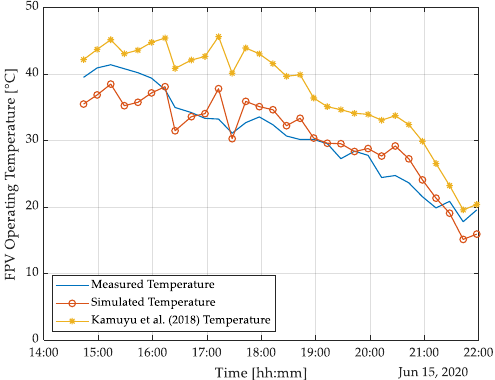
Figure 6. Measured FPV operating temperature compared to simulated FPV operating temperature